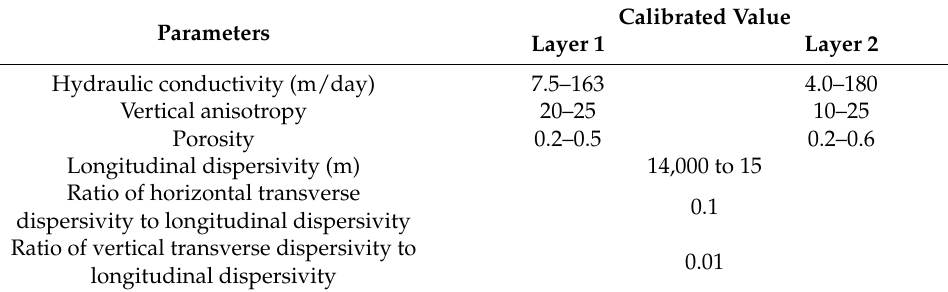
Table 4. Transient state calibrated parameter values.